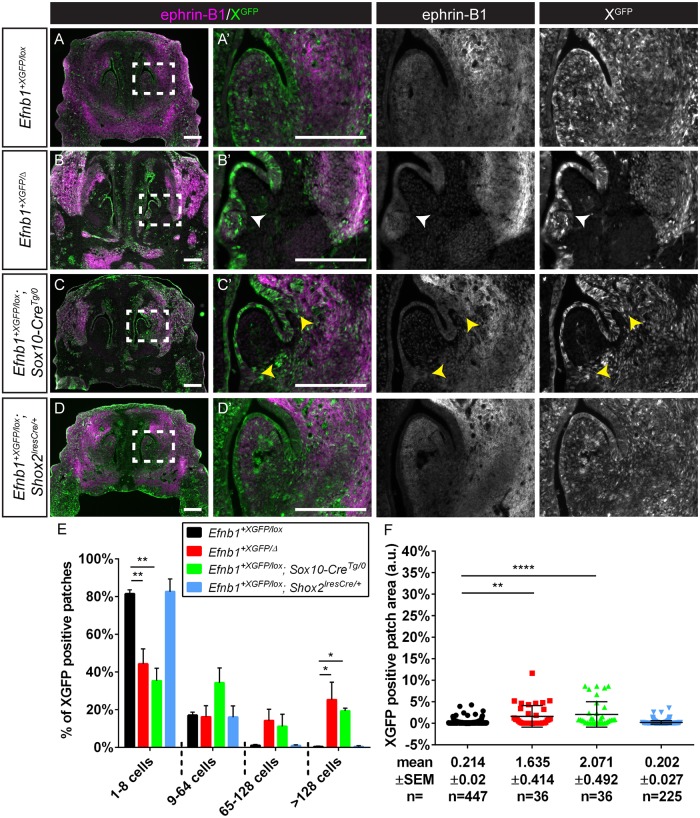
Craniofacial mesenchyme cell segregation correlates with local dysmorphology in the FNP.(A, A’) Immunostaining of frontal sections of control Efnb1+XGFP/lox embryos at E13.5 for EPHRIN-B1 (magenta) demonstrates strong expression in the LNP lateral to the nasal concha of the anterior frontonasal process (FNP). XGFP (green)-expressing cells are evenly distributed and intermixed with GFP non-expressing cells. (B, B’) In Efnb1+XGFP/Δ embryos with ubiquitous mosaicism for EPHRIN-B1 expression, cell segregation is evident throughout the anterior FNP, and bifurcation of the nasal concha occurs at an aberrant EPHRIN-B1 expression boundary (white arrowhead). (C, C’) Generation of EPHRIN-B1 mosaicism specifically in neural crest cells in Efnb1+XGFP/lox; Sox10-CreTg/0 embryos results in cell segregation visible throughout the anterior FNP and bifurcation of the nasal concha visible at EPHRIN-B1 expression boundaries (yellow arrowhead). (D, D’) Restriction of EPHRIN-B1 mosaicism to post-migratory neural crest cells using Shox2IresCre does not cause cell segregation or dysmorphology in the nasal conchae of the anterior FNP, as Shox2 is not expressed in this region. Scale bars, 200 μm. (E) Distribution of percentage of XGFP-positive patches of various sizes. Column height represents means of the distributions across all sections measured for a given genotype, error bars represent S.E.M., *, P<0.05.; **, P<0.01. (F) Patch sizes represented as scatterplots. Horizontal bars represent means, and error bars represent S.E.M. **, P<0.01; ****, P<.0001. Number of embryos analyzed is presented in S1 Table.